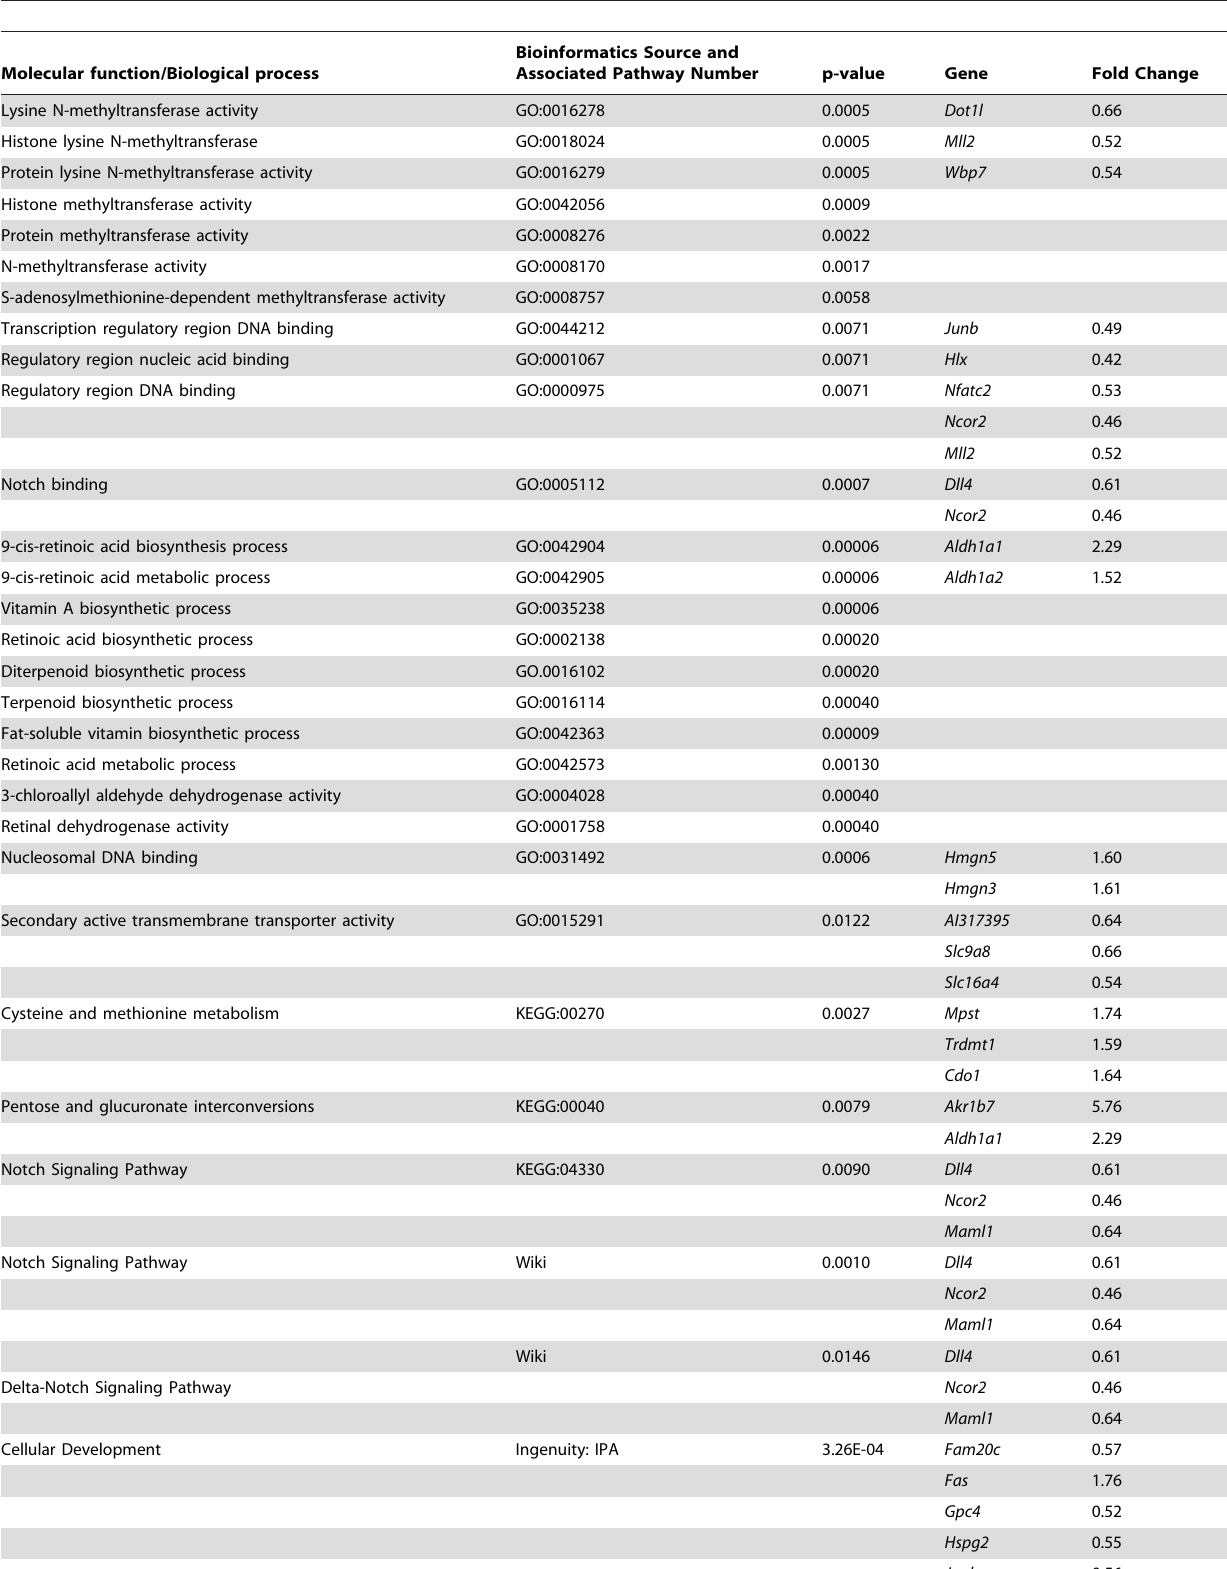
Table 2. Bioinformatics pathway analysis to predict molecular functions and biological processes significantly affected by the loss of Scx in heart valves at